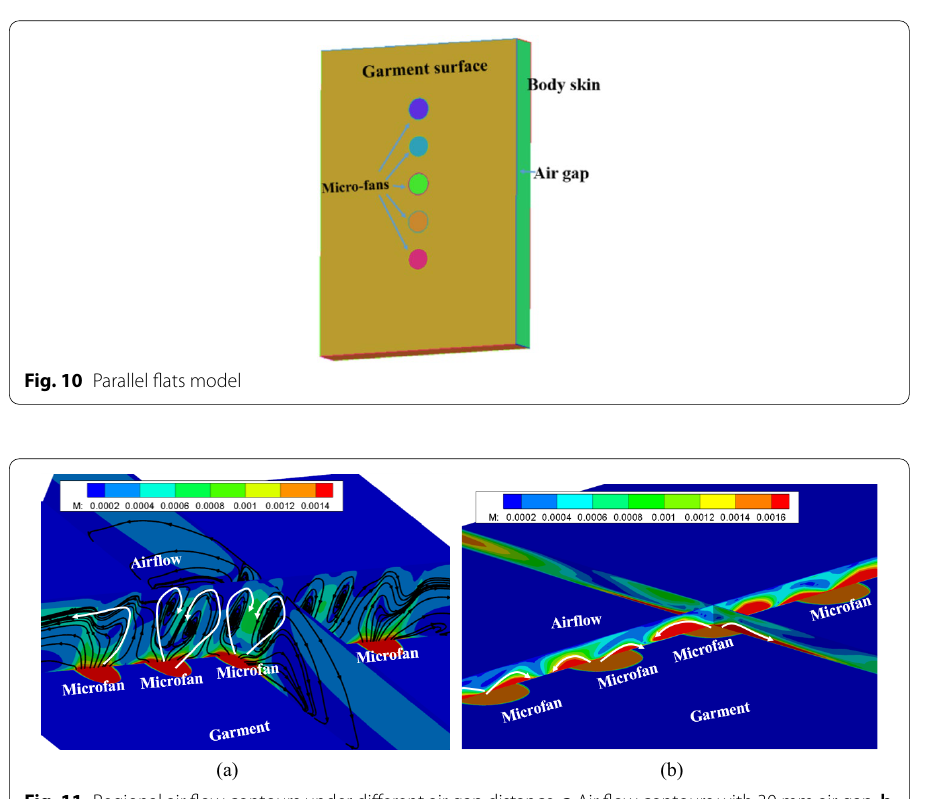
Fig. 11 Regional air flow contours under different air gap distance. a Air flow contours with 30 mm air gap, b air flow contours with 5 mm air